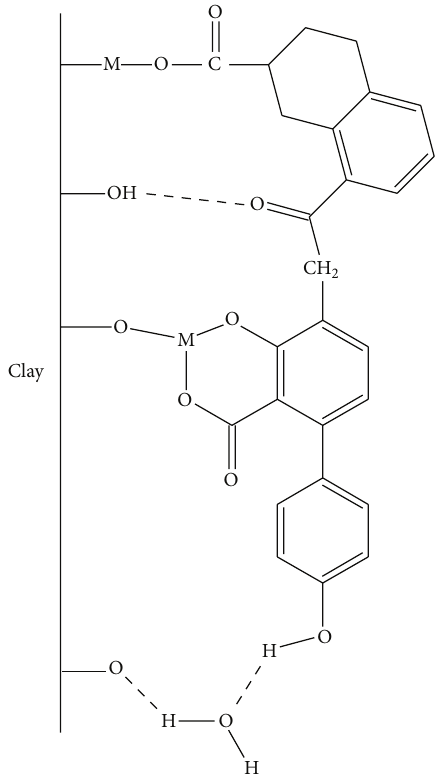
Figure 3: Interaction between humic substances and clays